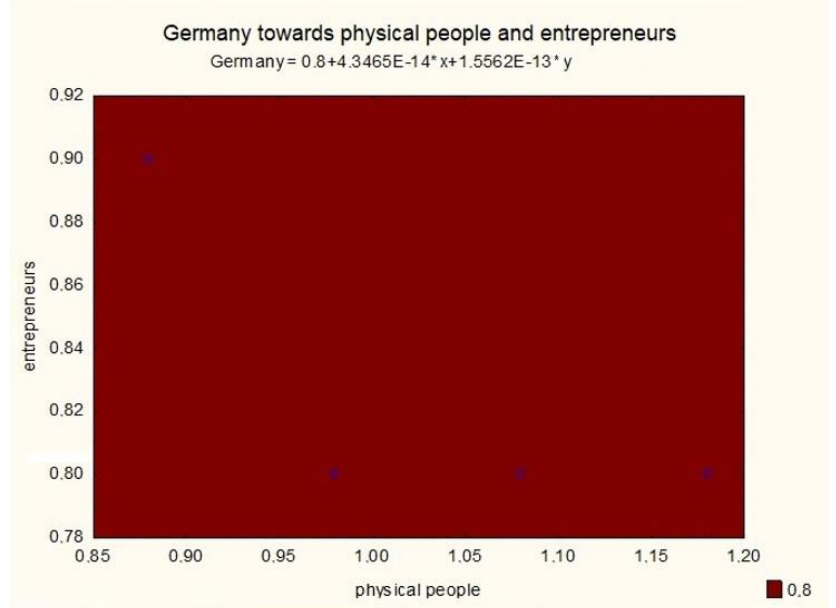
Figure 22. Contour chart verifying Poland ’ s chances of meeting the hydrogen assumptions. chances of meeting the hydrogen assumptions was made (Figure 23).